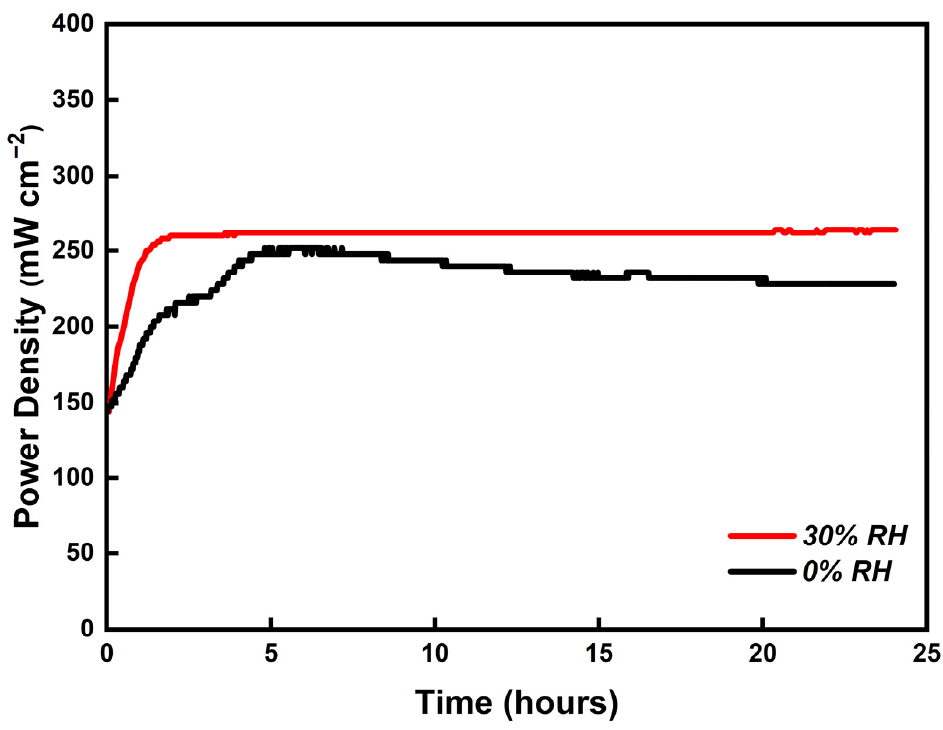
Figure 15. Stability tests of the single-cell with PBI/K MEA operating at 180 °C under 0 (black line) and 30% (red line) RH for 24 h (equal H 2 and O 2 flow rates at 0.4 L min − 1 ).